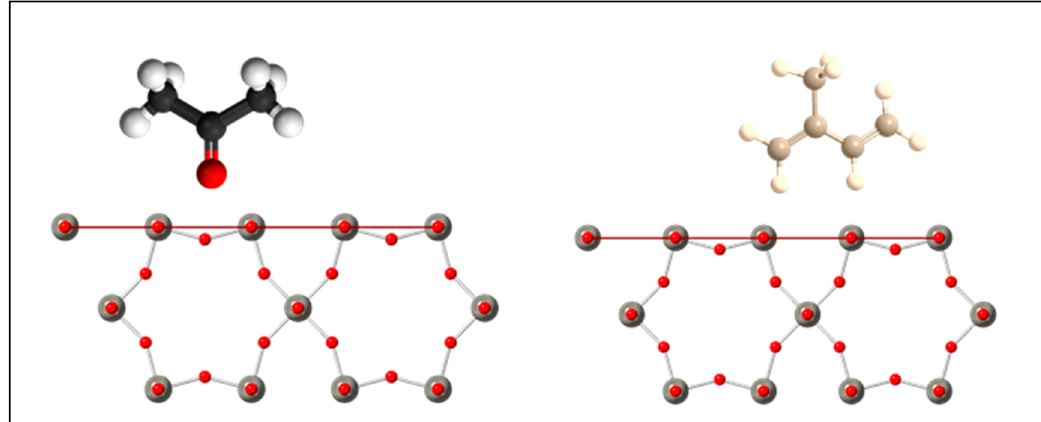
Figure 8. Potential molecule interaction orientation with the (100) facet of the h - WO 3 structure. Red horizonal line indicates the (100) plane. Red and grey spheres represent oxygen and tungsten atoms, respectively.